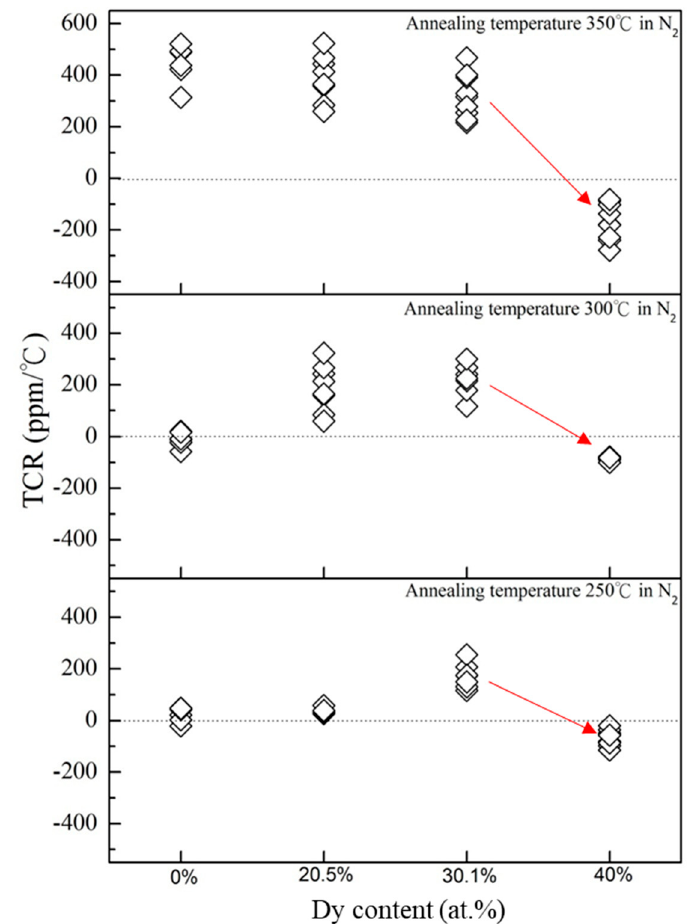
Figure 6. Temperature dependence of the temperature coefficient of resistance (TCR) of Cu–Mn films with various Dy contents annealed at different temperatures.